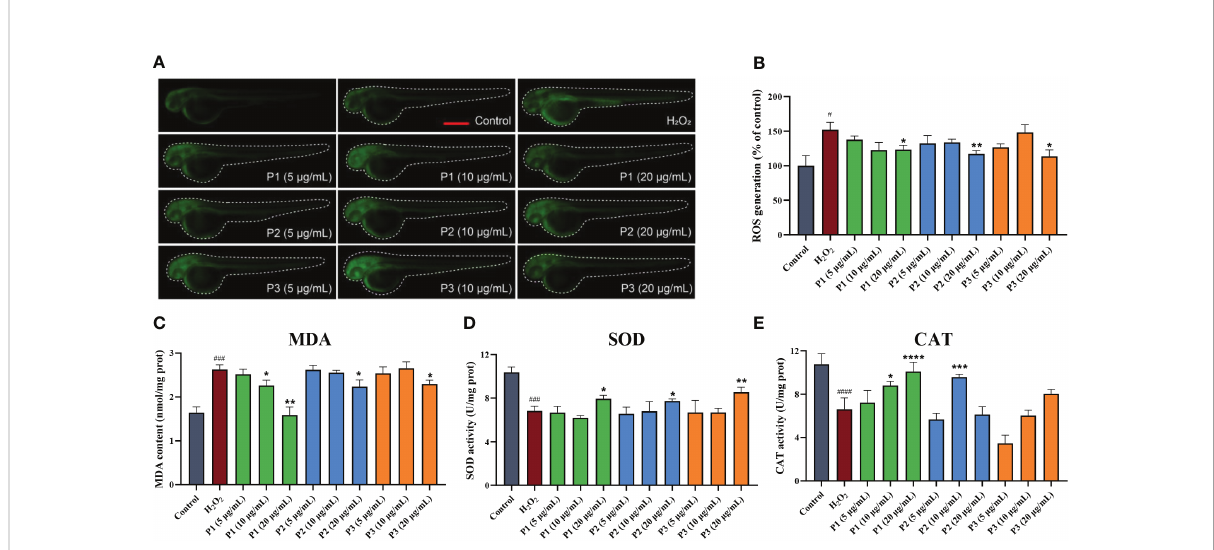
FIGURE 5 Three novel antioxidant peptides inhibited H 2 O 2 -induced oxidative stress in zebra fi sh. (A) The ROS fl uorescent images. (B) The levels of ROS production. (C) MDA level. (D) SOD activity. (E) CAT activity. * p < 0.05, ** p < 0.01, *** p < 0.001, **** p < 0.0001 vs. the model group. # p < 0.05, ### p < 0.001, #### p < 0.0001 vs. the control